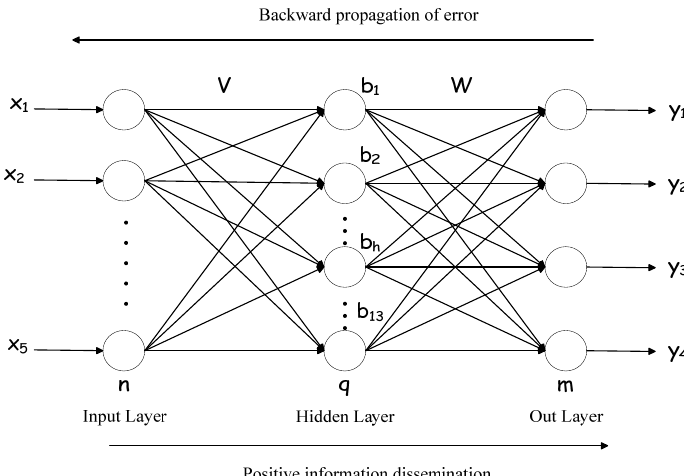
Figure 4. Structure diagram of Back Propagation (BP) neural network.